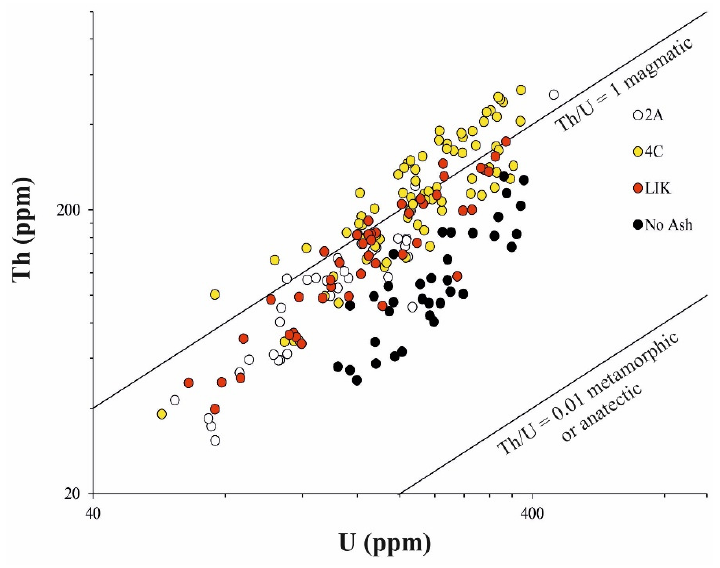
Figure 6. Th vs. U diagram for the here studied zircons, according to [31]. White circles: 2A; yellow circles: 4C; red circles: LIK; black circles: No Ash.